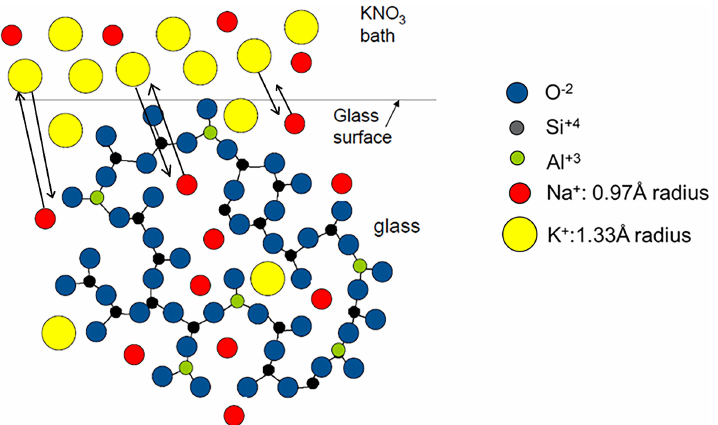
Figure 3. Depiction of the K + /Na + ion-exchange process using KNO 3 molten salt as the source of K + ions. The glass considered here is an aluminosilicate glass with an alkali oxide (Na 2 O) as glass modifier. The kinetics of the process is described by diffusion equations. Reproduced from [24] with permission by John Wiley and Sons.